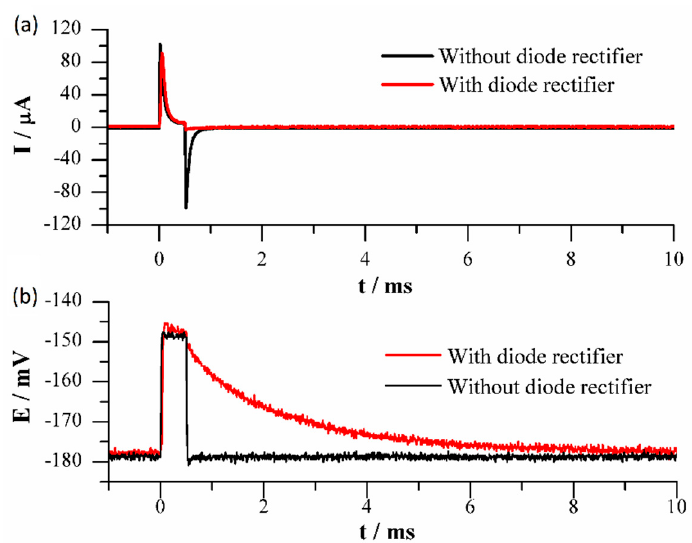
Figure 3. Curves of the response of ssDNA / Au electrodes to a double potential step of 30 mV. Current ( a ) and potential ( b )